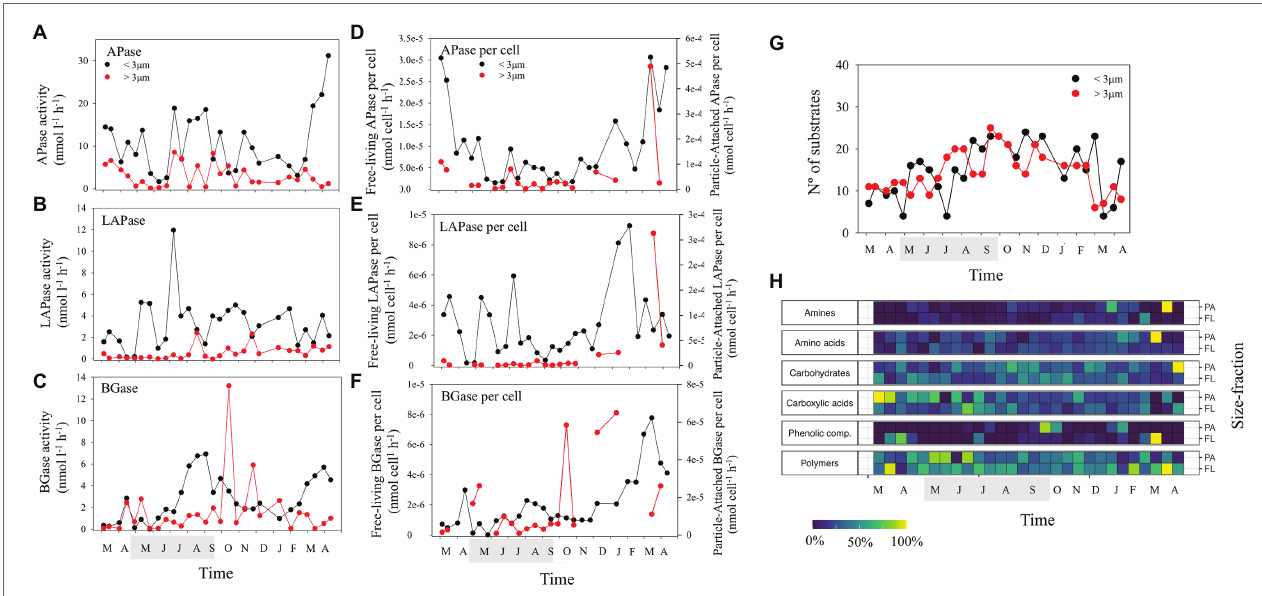
FIGURE 3 | Temporal dynamics in bulk and per cell extracellular enzymatic activities of: (A,D) alkaline phosphatase (APase), (B,E) leucine aminopeptidase (LAPase), and (C,F) β -glucosidase (BGase). Temporal dynamics in (G) the number of substrates used, and (H) the relative substrate use in the two size-fractions studied (normalized per substrate). The shaded period in the x-axis corresponds to